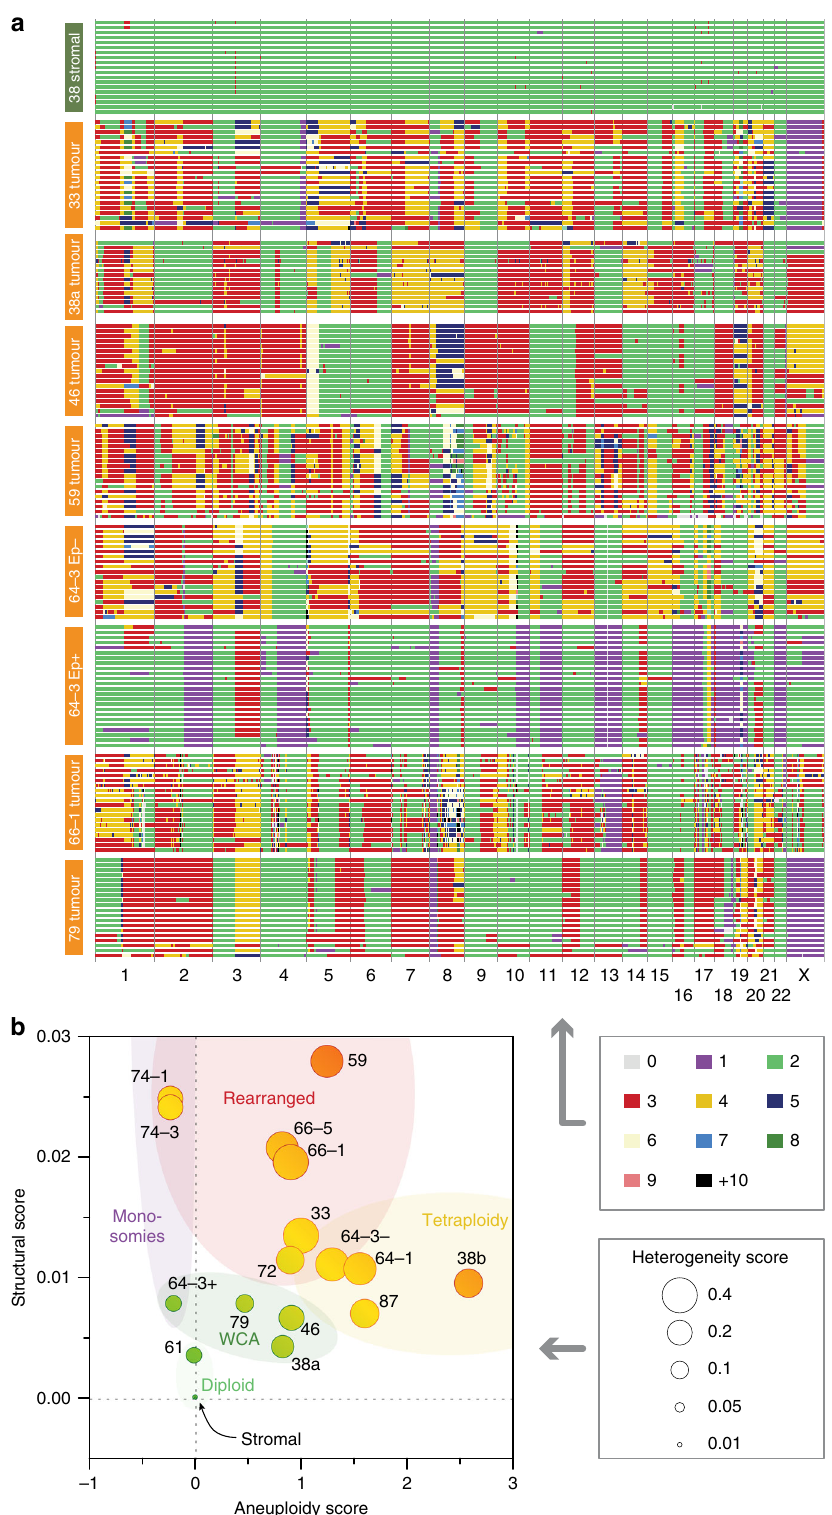
Fig. 6 scWGS karyotyping. a Genome-wide chromosome copy number pro fi les determined by single-cell whole-genome sequencing showing aneuploidies and rearranged chromosomes in tumour cells. Each row represents a single cell, with chromosomes plotted as columns and colours depicting copy number state. b Bubble plot showing structural, aneuploidy and heterogeneity scores. See also Supplementary Fig. 3. Source data for panel b are provided as a Source Data fi